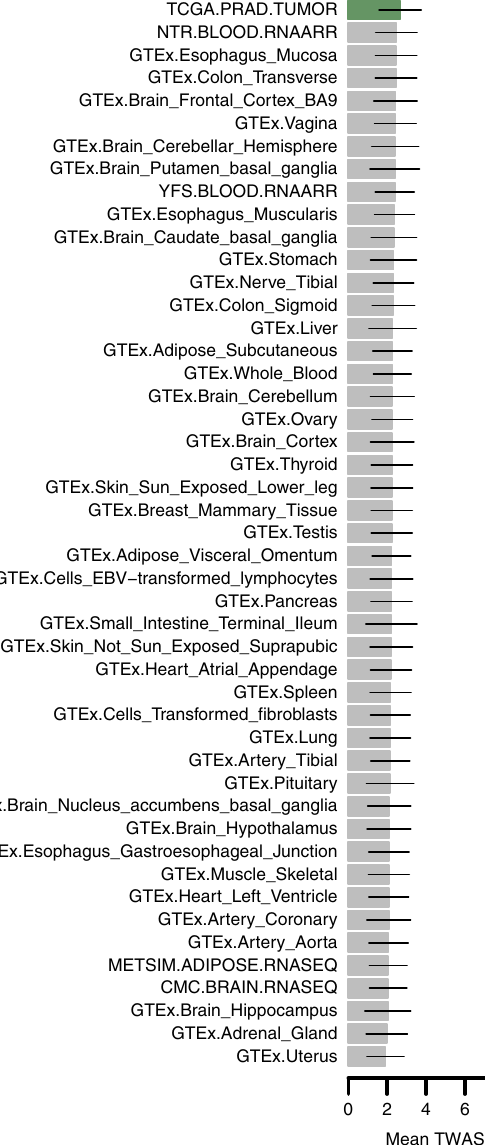
Fig. 4 Average TWAS association statistics for genes predicted in each expression panel. Each bar plot corresponds to the average TWAS association statistic using all gene models from a given expression reference panel. Lines represent 1 standard-deviation estimated using the median absolute deviation under normality assumptions. Normal and tumor prostate tissues are marked in green. All other tissues are marked in